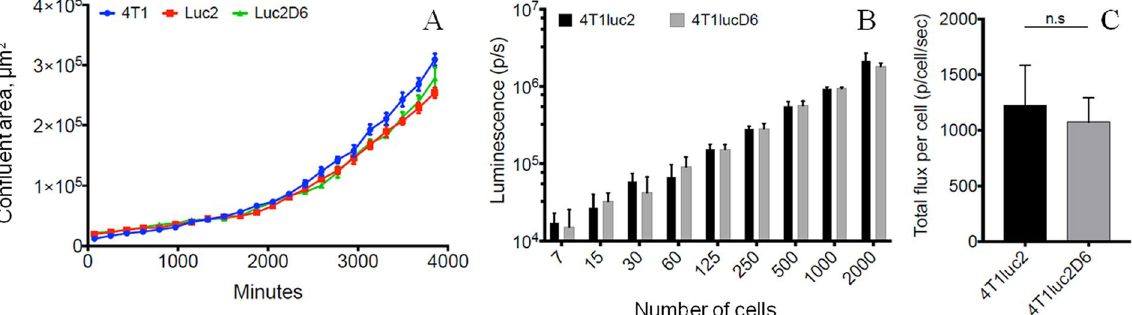
Figure 1. Growth rates of the murine adenocarcinoma 4T1 cell line and its sublclones expressing luciferase 4T1luc2D6 and 4T1luc2. The time course of the proliferation of the parental 4T1, and 4T1luc2D6 and 4T1luc2 (PerkinElmer) clones as determined using Nikon Biostation CT (Nikon, Japan) with STDV ( A ); Bioluminescence from 4T1luc2 and 4T1luc2D6 cells in culture assessed by bioluminescent imaging (Spectrum CT, Perkin Elmer) ( B ); Average level of bioluminescence of 4T1luc2 and 4T1luc2D6 cells (photons/cell/sec) ( C ). Results from five independent measurements. No significant difference between any of the analysed parameters (p > 0,05; Mann Whitney